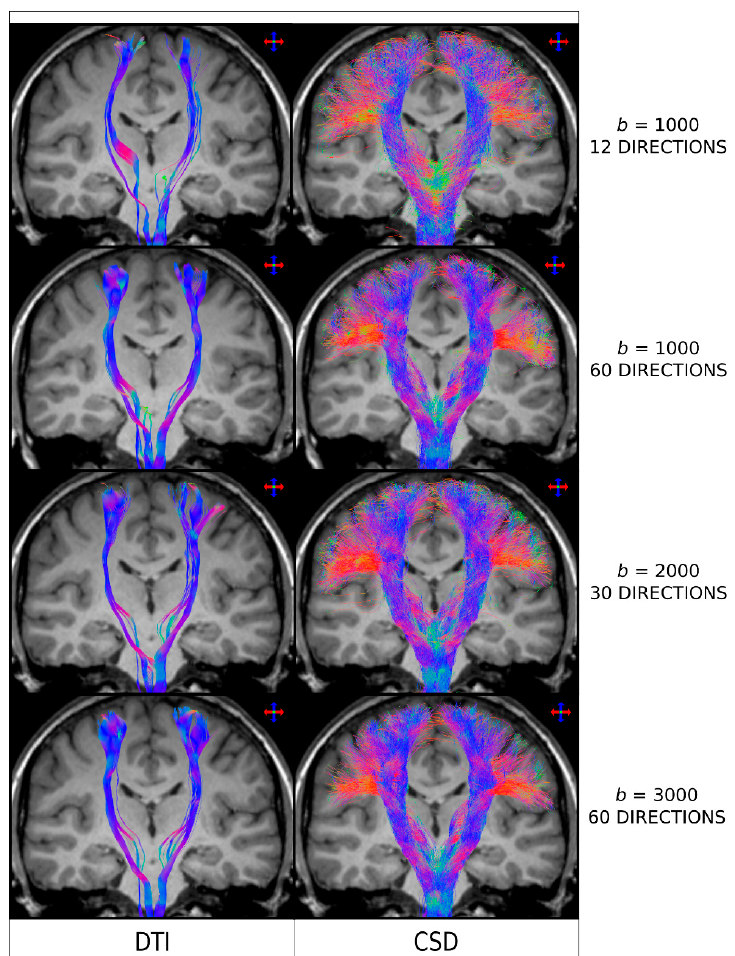
Figure 4. Fibre-tracking results on a healthy human subject obtained using a seed region in the brainstem and target regions in the sensorimotor cortices. Coronal T1-weighted images overlaid with tractography results using DTI combined with a deterministic algorithm (left column) and CSD combined with a probabilistic algorithm (right column), for a range of diffusion MRI protocols (as indicated by the b-value, in s/mm 2 , and number of directions). The colour-coding indicates the fibre orientation (same convention as in Figure 2). DTI: Diffusion Tensor Imaging; CSD: constrained